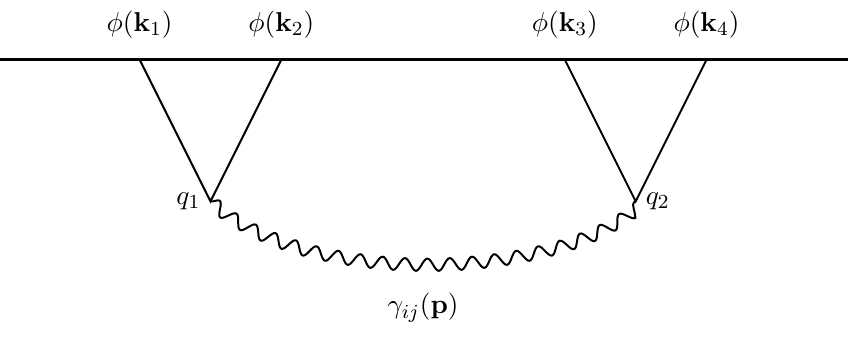
Figure 11 . The s -channel graviton-exchange contribution to ψ 4